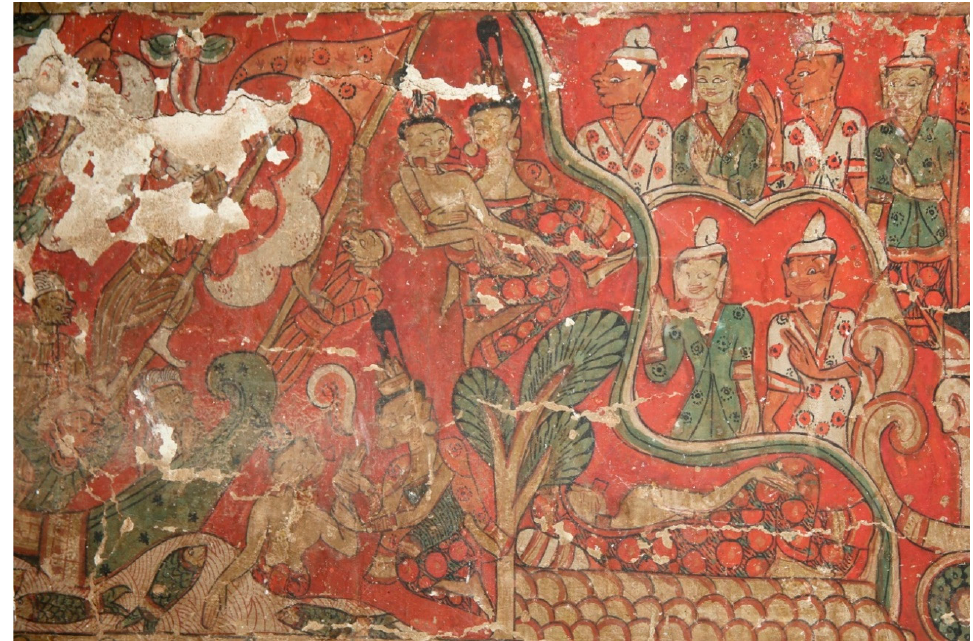
Figure 7. Anaint, 18th century. Foreigners as merchants in the Mah ā janaka J ā taka, identifiable by their ugly facial features and attire.